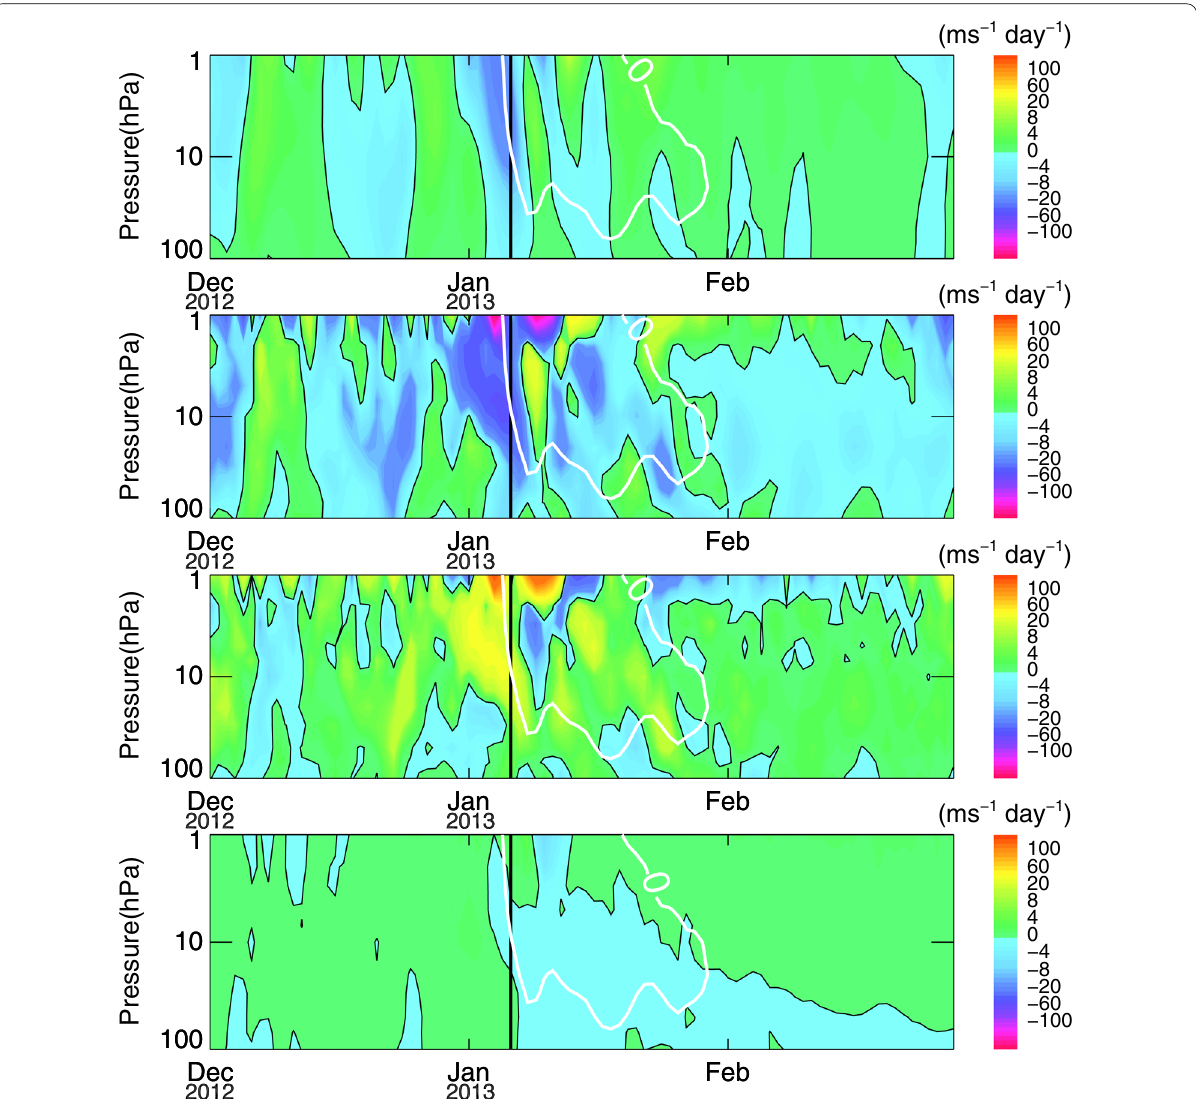
Fig. 10 Latitude versus time structures of the u t (first row), the D F (second row), the meridional (third row) and vertical (last row) advection of zonal momentum at 50–80 ◦ N . Black thick vertical line denotes the SSW central date. White contours represent zero zonal winds. Black thin contours represent 0 ms − 1 day −